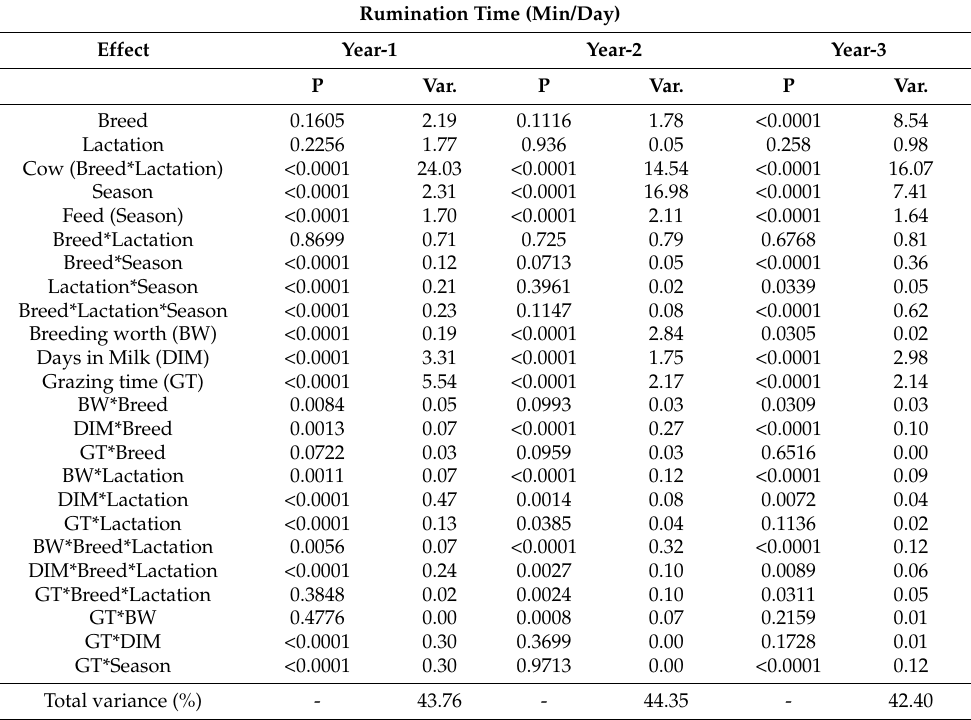
Table 4. P values and the variance explained for the linear relationship between grazing time and rumination time while accounting for the effects of breed, lactation year, cow within breed and lactation year, season, supplementary feeds within the season, breeding worth (BW) index, days in milk (DIM), and their interactions using a mixed-effects model with the cow ( n = 54 ) as a random factor, and BW, DIM, and grazing time (GT) as continuous